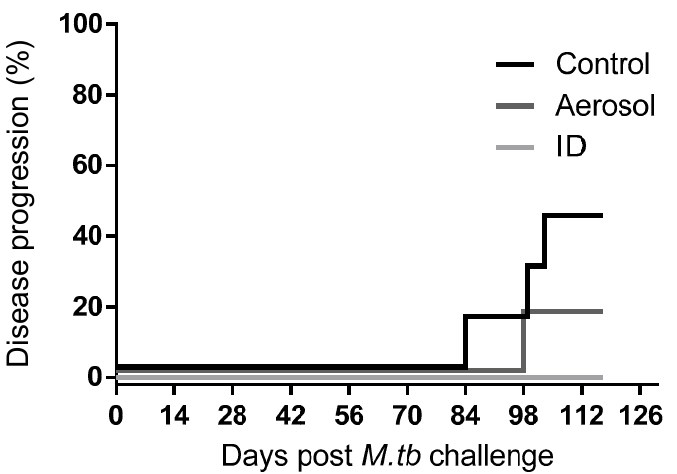
Figure 2. Kaplan–Meier plot indicating proportions of vaccinated and unvaccinated non-human primates (NHPs) able to control disease progression following ultra-low dose aerosol challenge with M. tuberculosis .